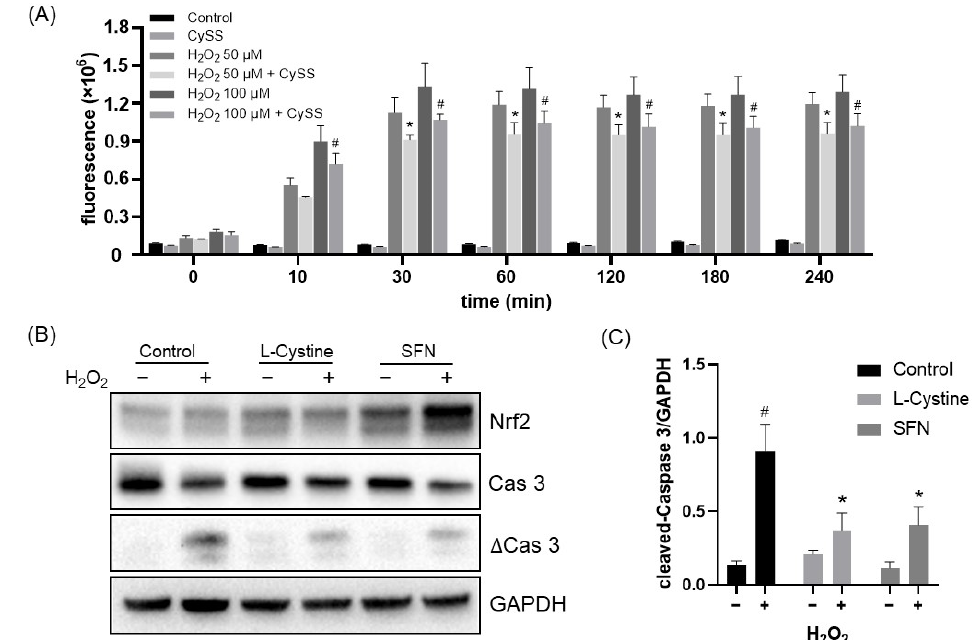
Figure 12. L-Cystine Reduces ROS Generation and Protects Against Oxidant-Induced Cell Death. HeLa cells were pre-treated with 0.8 mM L-Cystine (CySS) for 16 h before 30-min incubation with 2 ′ ,7 ′ -dichlorofluorescein diacetate (DCFDA, A). H 2 O 2 (50, 100 μ M) was added to cells to induce hydroxyl radical formation ( A ). The fluorescence was recorded by a microplate reader at the time point indicated ( A ). To induce apoptosis, following 16 h of pretreatment with 0.8 mM L-Cystine or 5 µ M SFN, the cells were treated with 1 mM H 2 O 2 for 6 h before harvesting for Western blot ( B , C ). The data are shown as means ± SD from triplicates ( A ) or from three independent experiments by quantification of band intensities with NIH ImageJ ( C ). * or # indicates statistically significant compared to 50 or 100 µ M H 2 O 2 treatment alone, respectively, at the same time point ( A ), or compared to H 2 O 2 treatment alone or to control without H 2 O 2 treatment, respectively ( C ), by two-way ANOVA, corrected by Turkey’s multiple comparisons test ( A , C ).